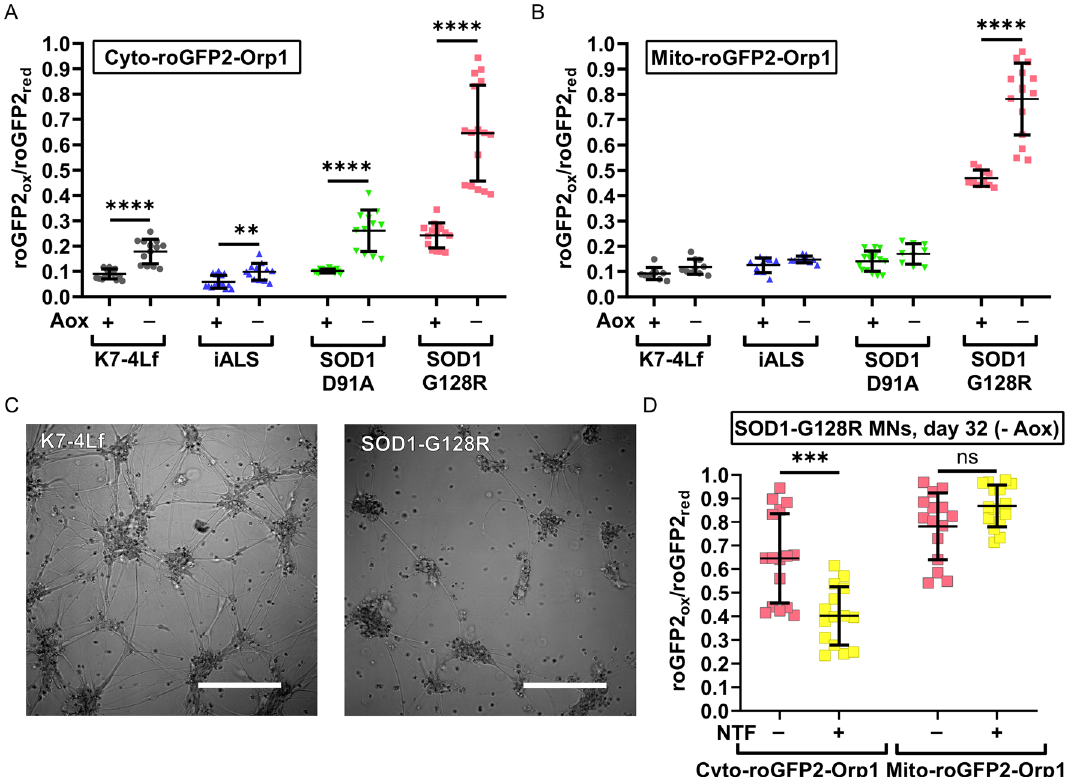
Figure 5. Effect of the antioxidant deprivation on the basal H 2 O 2 level in the cytoplasm and mitochondria of motor neurons (MNs). Values were obtained by analyzing the microscopic images of the respective MNs. Basal levels of H 2 O 2 in the cytoplasm ( A ) and mitochondria ( B ) of MNs were measured on the differentiation days 29 (Aox+) and 32 (Aox−). C Representative images of the K7-4Lf and SOD1-G128R MN morphology in the antioxidant-free medium (differentiation day 32, DIC contrast), scale bar 200 μm. ( D ) Basal levels of H 2 O 2 , measured on the differentiation day 32 in SOD1-G128R MNs cultured with or without neurotrophic factors (NTFs) in the culture medium during maturation. Data (N = 10–16 fields of view, collected from MNs, derived from three iPSC lines with the same genotype) are the mean ± standard deviation. Ns—non significant, **p < 0.01,***p < 0.001, ****p < 0.0001, Welch t-test. The same datasets of cytoplasmic and mitochondrial H 2 O 2 levels in SOD1-G128R (-NTF) were used in ( A – C ). The datasets used to present the cytoplasmic and mitochondrial oxidation on the differentiation day 29 (Aox+) for K7-4Lf, iALS, SOD1-D91A, and SOD1-G128R MNs in the panels A and B are the same as in Fig.